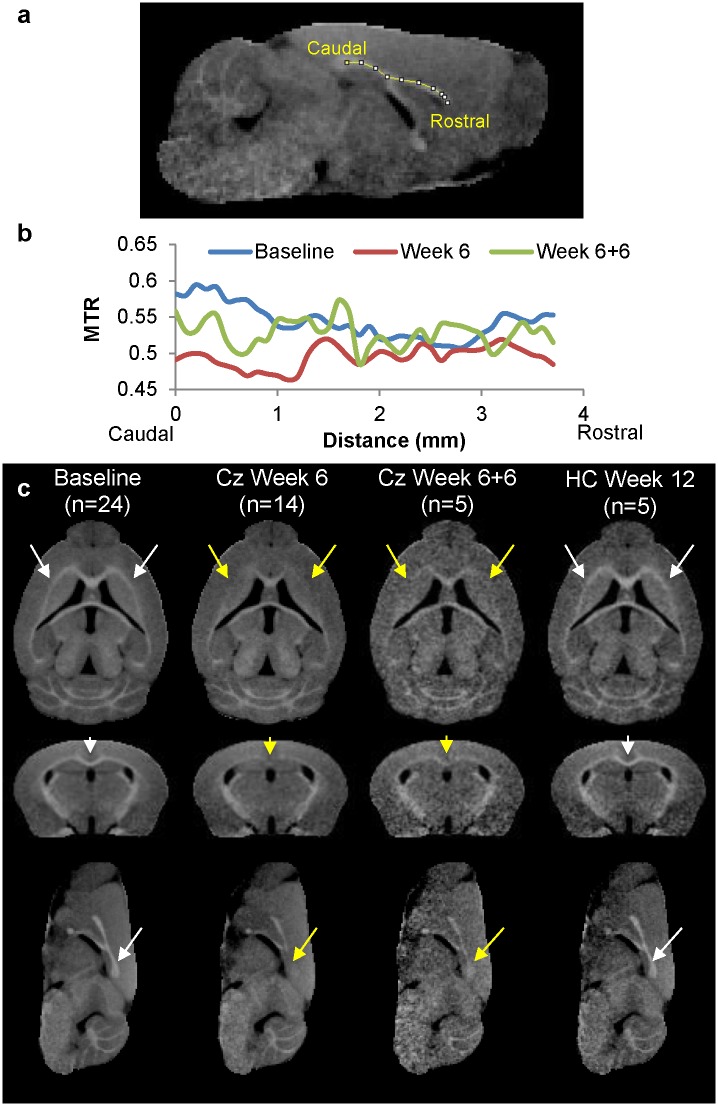
Population Average Orthogonal MTR Parametric Maps.(a,b) Population average MTR projection along midsagittal CC from Caudal (splenium) to Rostral (genu) at Baseline (blue), Week 6 (red), and Week 6+6 (green). (c) Population-average MTR maps at baseline, Cz Week 6, Cz Week 6+6, and HC Week 12. Note that SNR increases with the number of images averaged, resulting in poorer image quality in Cz Week 6+6 and HC Week 12 images.